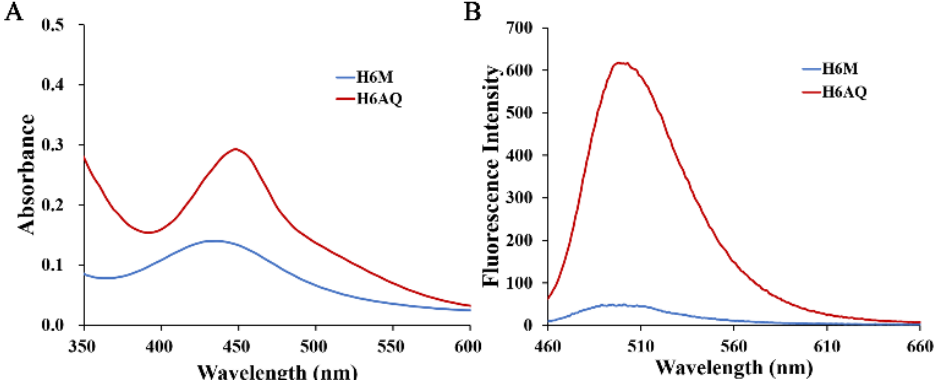
Figure 3. ( A ) Normalized absorption spectra of H6M (5 μ M) and H6AQ (5 μ M) and ( B ) fluorescence emission spectra of H6M (5 μ M) and H6AQ (5 μ M) in aqueous 10% ( v / v ) DMSO ( λ ex = 450 nm, pH = 3.98).